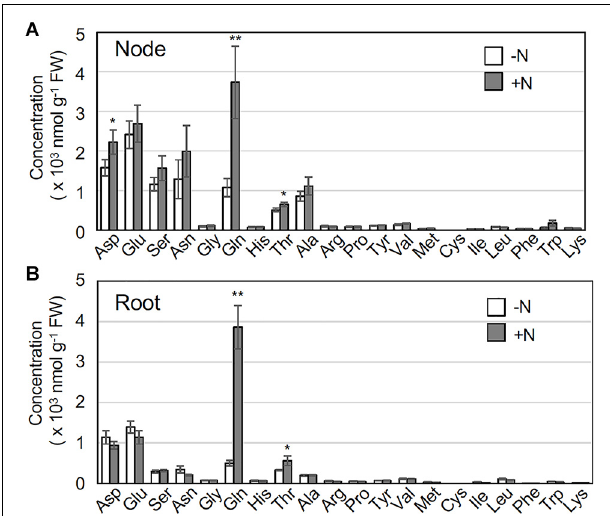
FIGURE 5 | Effects of nitrogen application on the expression of OlFC1 in rhizome buds. Young ramets having rhizomes at a similar growth stage were hydroponically grown in a low-N (200 µ M NH 4 NO 3 ) medium for 2 weeks. The ramets were subsequently transferred to culture media containing no nitrogen (-N) or 2 mM NH 4 NO 3 (+N) and incubated for 6 h and 10 h. Total RNA prepared from the samples was subjected to RT-qPCR analysis. Transcript levels were normalized by OlUBQ1 and expressed as relative values with respect to the value in the -N treatment. Values are the means ± SE ( n = 3). ** P < 0.01 (Student’s t test) compared to the -N